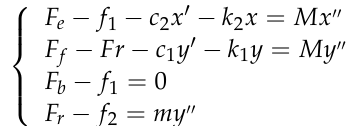
Figure 19. Bottom structure.